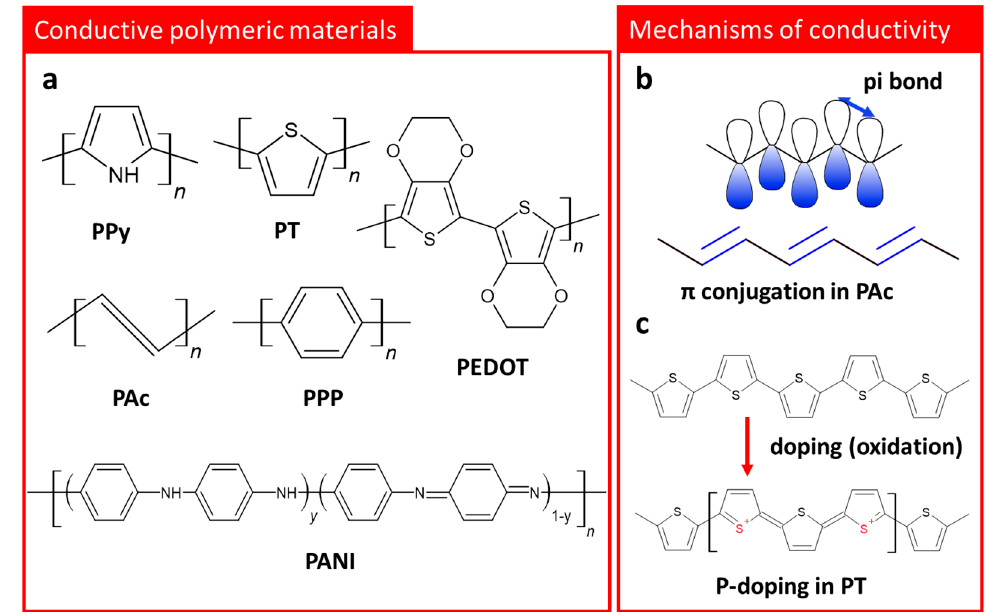
Figure 1. ( a ) Chemical formulas of various conducting polymeric materials: PPy, PT, PAc, PPP, PEDOT, and PANI. Schematic description of ( b ) conjugated π -bonds in PAc, and ( c ) p-doping mechanism in PT chain through oxidation.